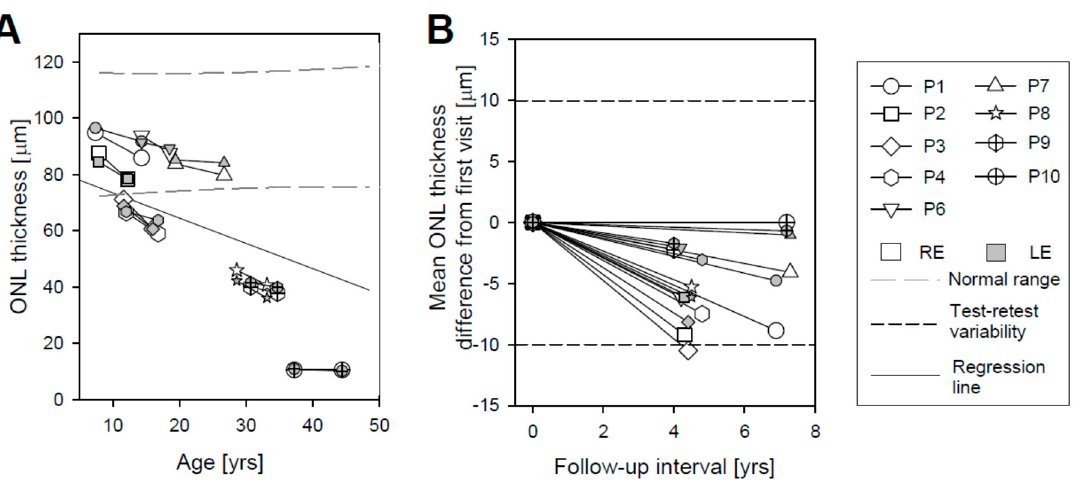
Figure 3. Foveal outer nuclear layer (ONL) measurements in GUCY2D –LCA patients at two visits. ( A ) ONL thickness as a function of patient age shows a trend toward reduction of foveal ONL with increasing age. Serial data are connected by solid lines. Black long dashed lines represent the range of normal ONL thickness for comparison [19]. Gray dashed line is the regression line. ( B ) Difference in foveal ONL thickness from first visit versus follow-up interval. Short dashed lines show test–retest variability.